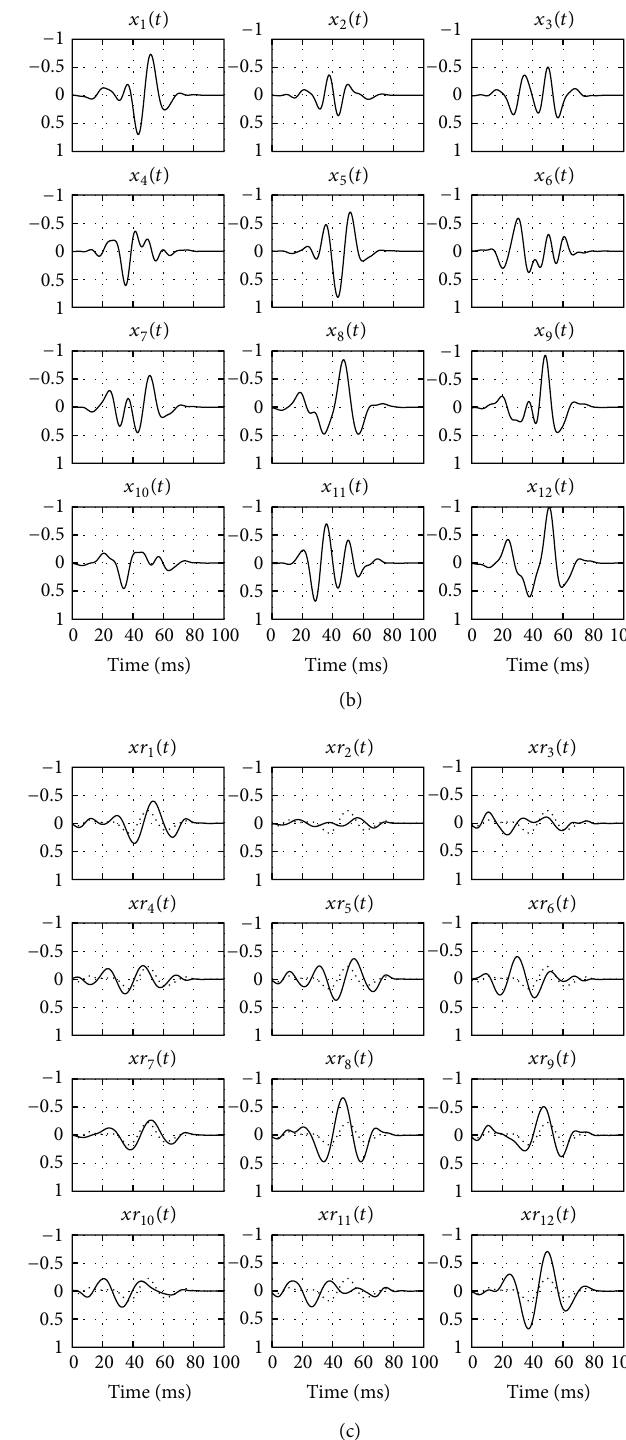
Figure 3: Diagram for “eigenspace filtering”. (a) Algorithm flowchart for eigenspace filtering. (b) Set of 𝑥 𝑘 (𝑡) signals from Figure 1(b) before eigen filtering. (c) Set of 𝑥𝑟 𝑘 (𝑡) signals after filtering with the extracted SSEP signal, 𝑠(𝑡) , shown by dotted line superimposed on the signals for easy